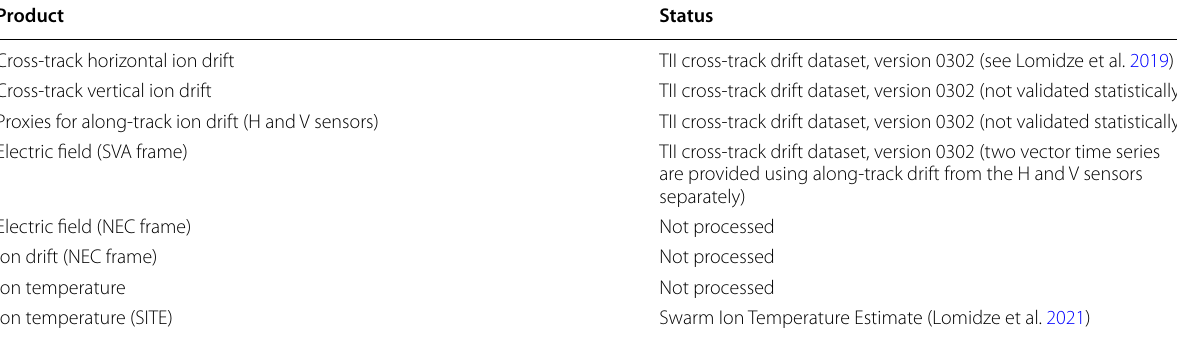
Table 7 TII-related data products and processing status